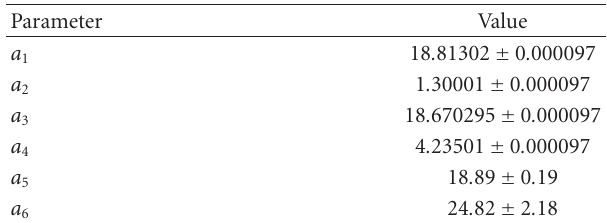
Table 2: Values for the relevant parameters in Dostrovsky’s empiri- cal